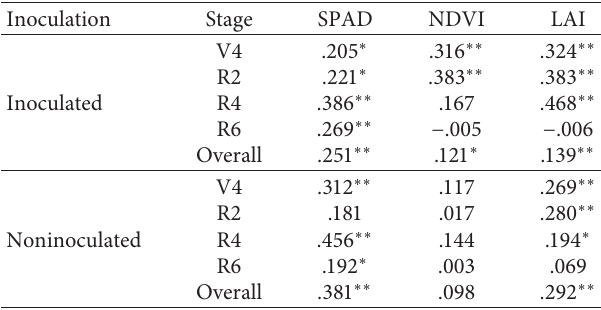
Table 2: Correlation coefficient of SPAD, NDVI, and LAI traits at different stages with